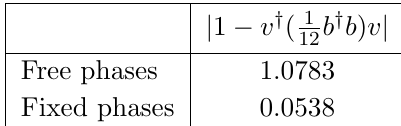
Table 1. We averaged over 10 6 random draws of the vector v . The phases were (cid:12)xed by taking the element wise absolute value of the random